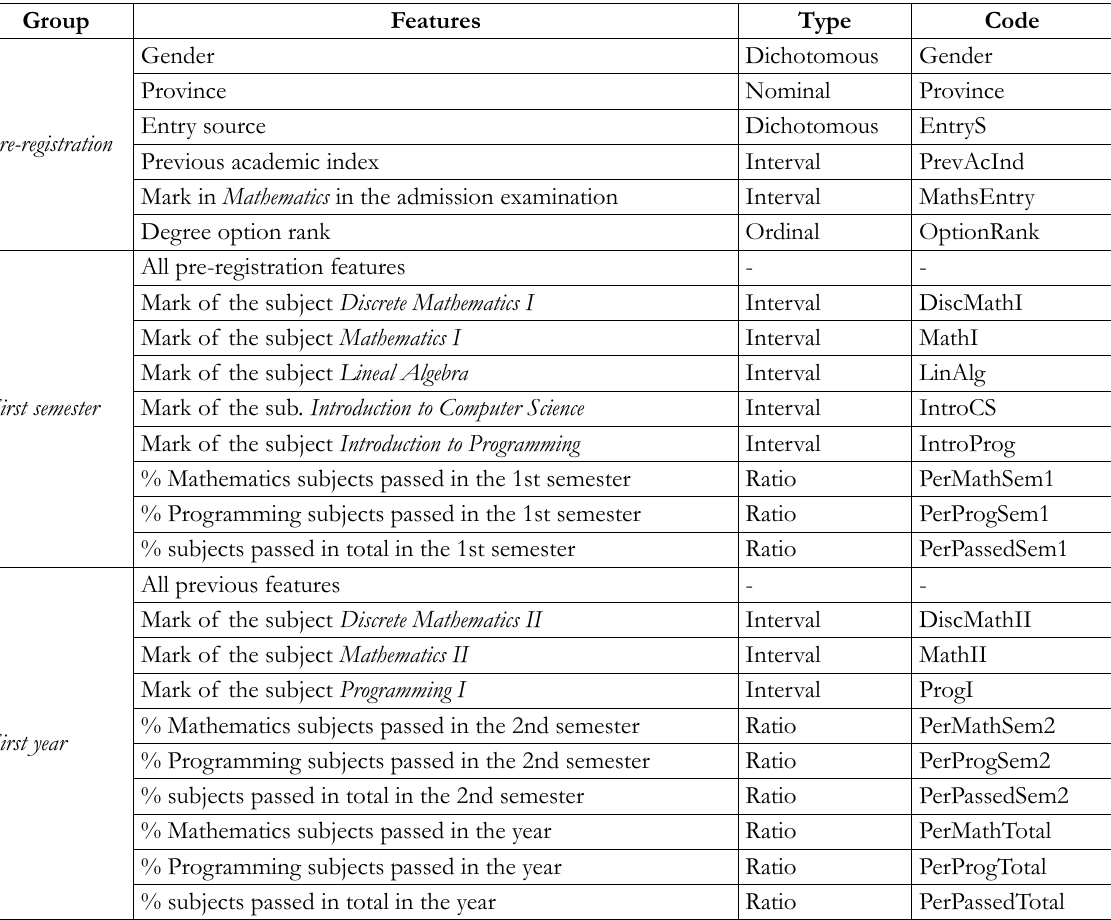
Table 1. Features considered for the detection of